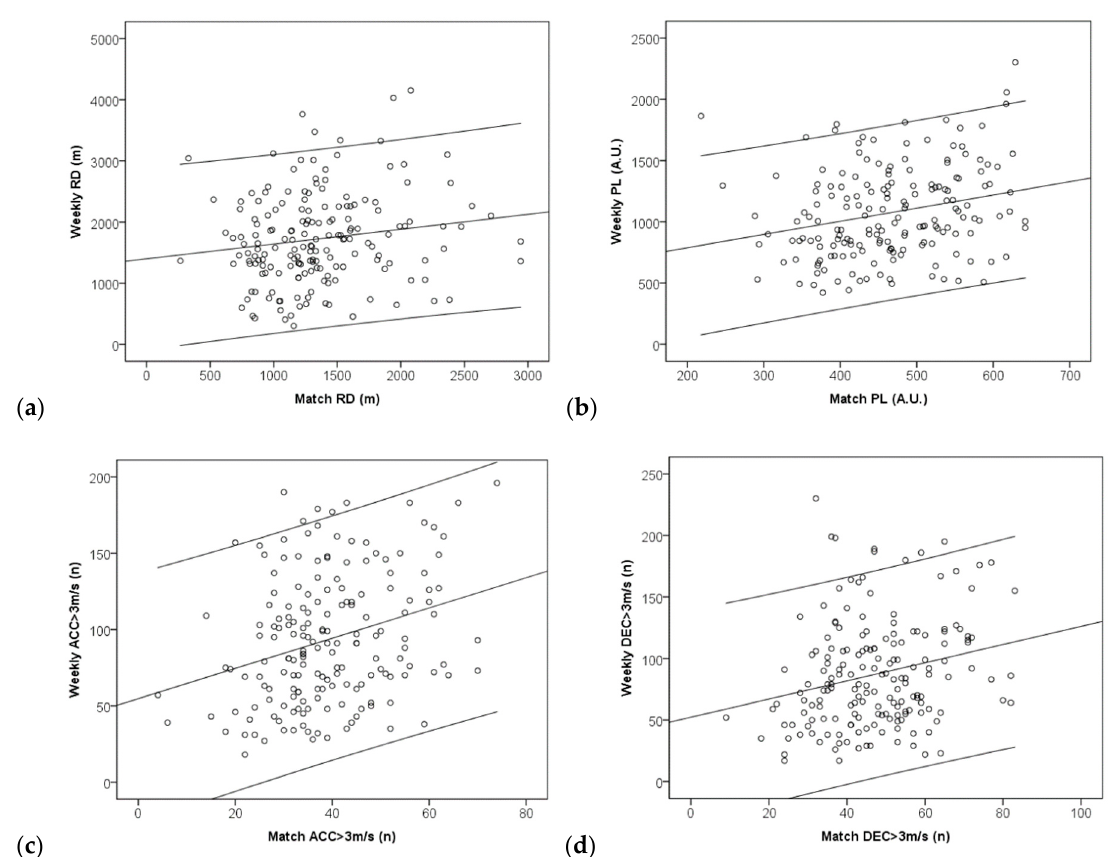
Figure 4. Scatter plots of relationships between accumulated weekly training external load and the match demands for the same week: ( a ) running distance, ( b ) player load, ( c ) total